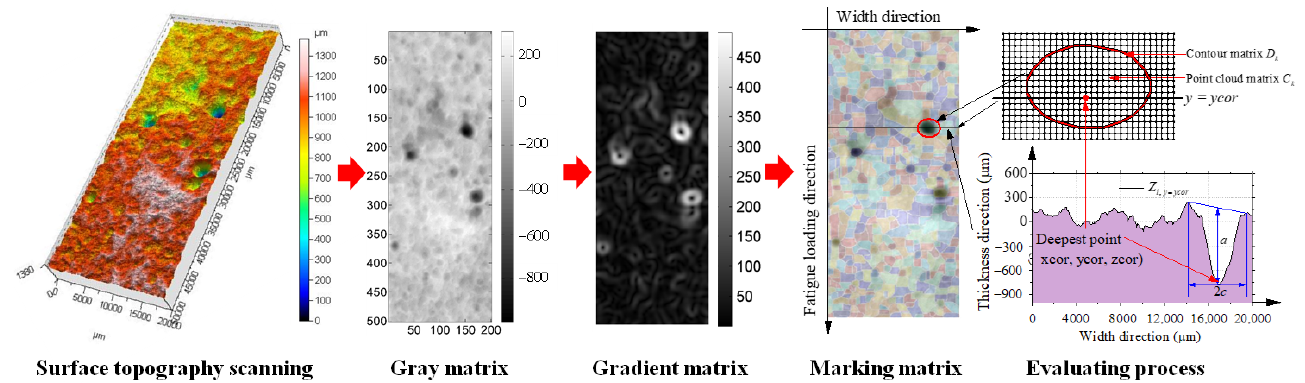
Figure 7. Identification, extraction and evaluation process of rust pits on the surface of corroded steel plate. steel